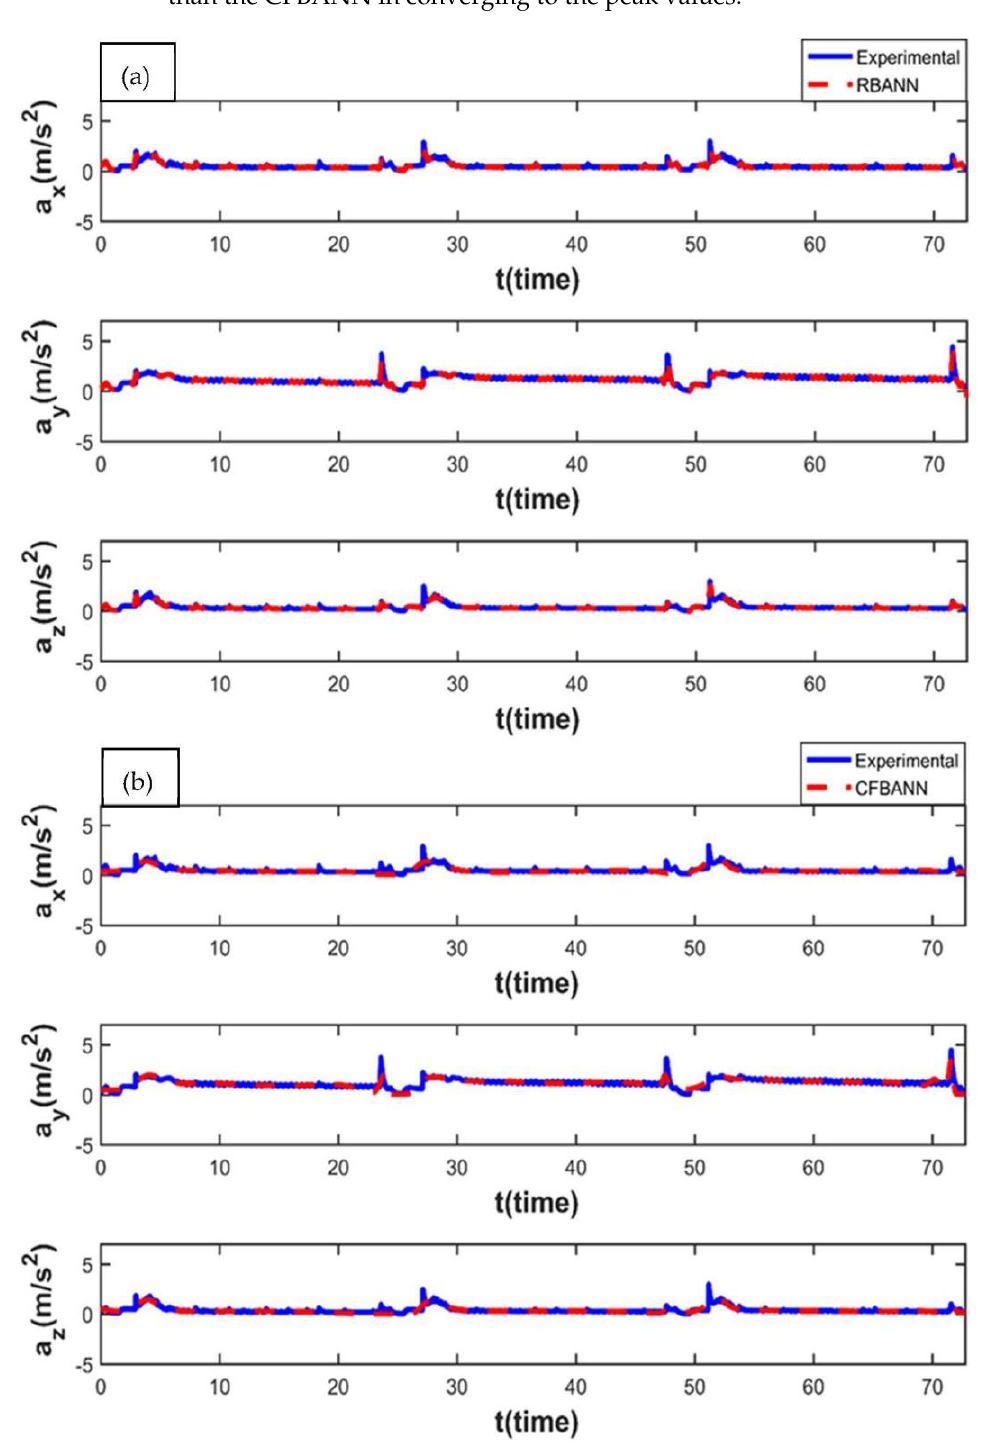
Figure 14. Experimental and ANN results obtained for the working condition of 20 s and 6.25 bar: ( a ) RBANN; ( b ) CFBANN.